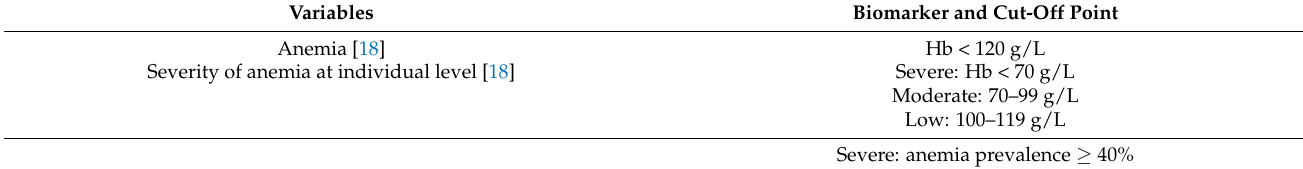
Table 1. Variables used for the evaluation of women of reproductive age. Cuba